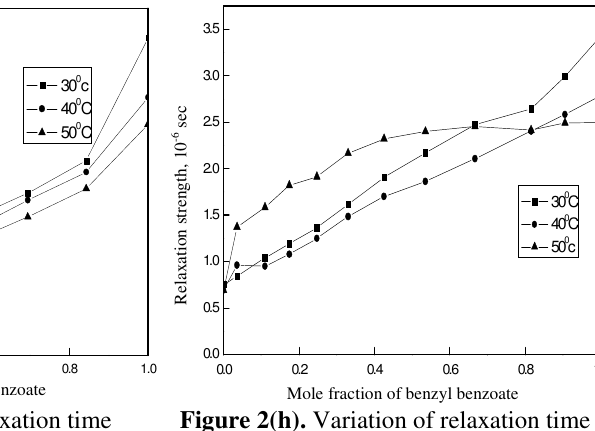
Figure 1(h). Variation of relaxation time with mole fraction of benzyl benzoate in the mixture of benzyl benzoate + acetonitrile